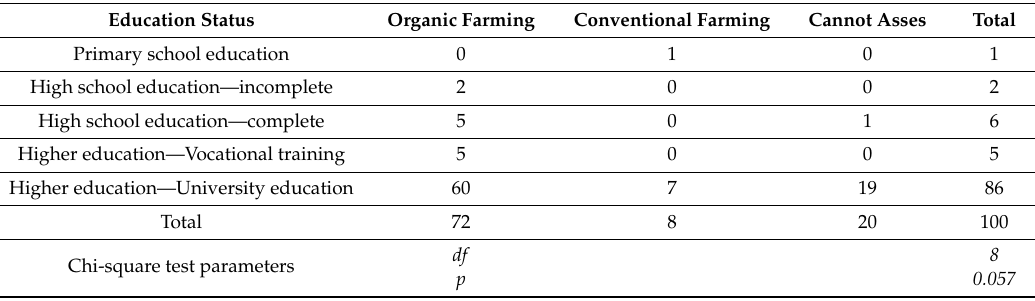
Table 6. Relation between education level and perceptions of sustainable farming methods.